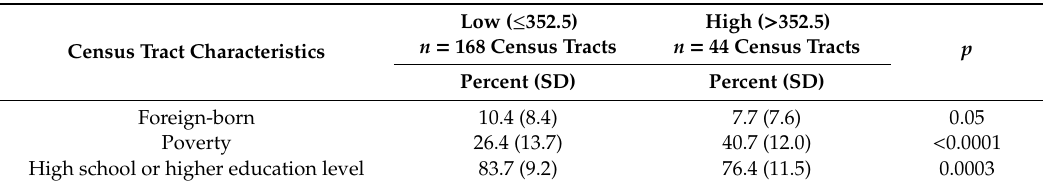
Table 2. Census tract characteristics (212 Philadelphia census tracts) by annual census tract violent crime incidents per square kilometer,